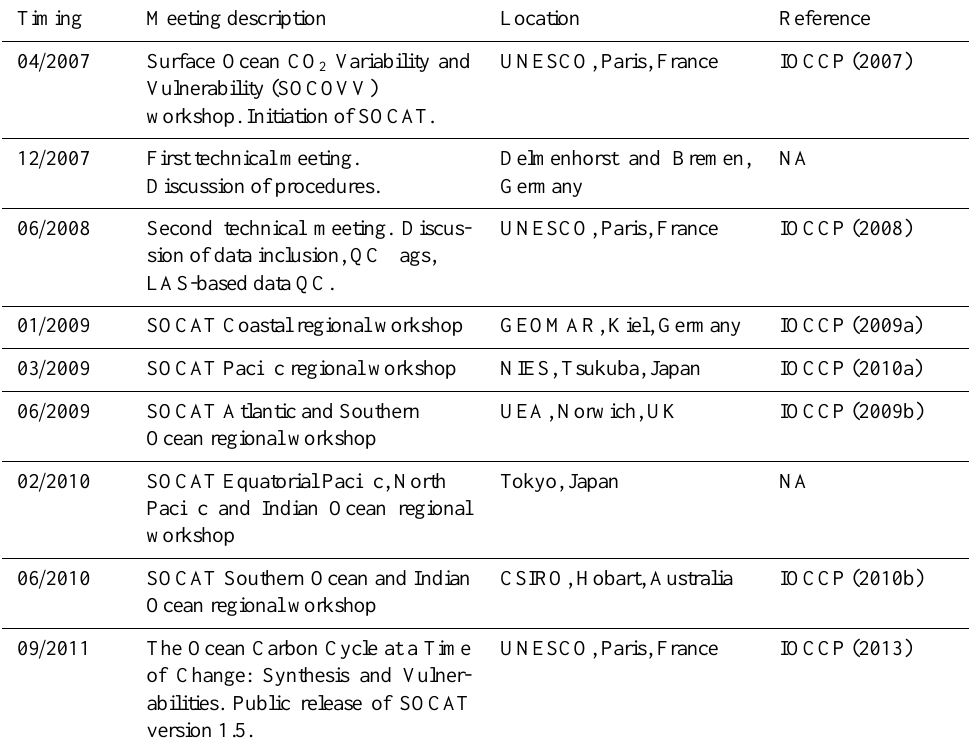
Table 1. Meetings for SOCAT version 1.5. Abbreviations are explained in the text and acknowledgements. Timing